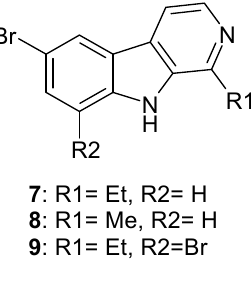
Figure 3. Brominated-  -carboline structures isolated from Aglophenia pleuma